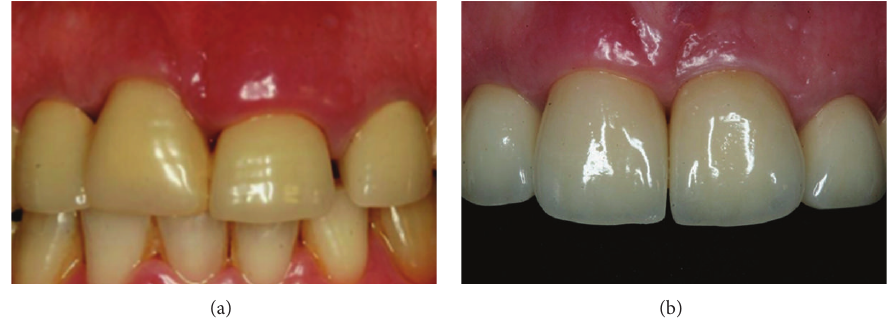
Figure 12: (a) Initial and (b) final clinical